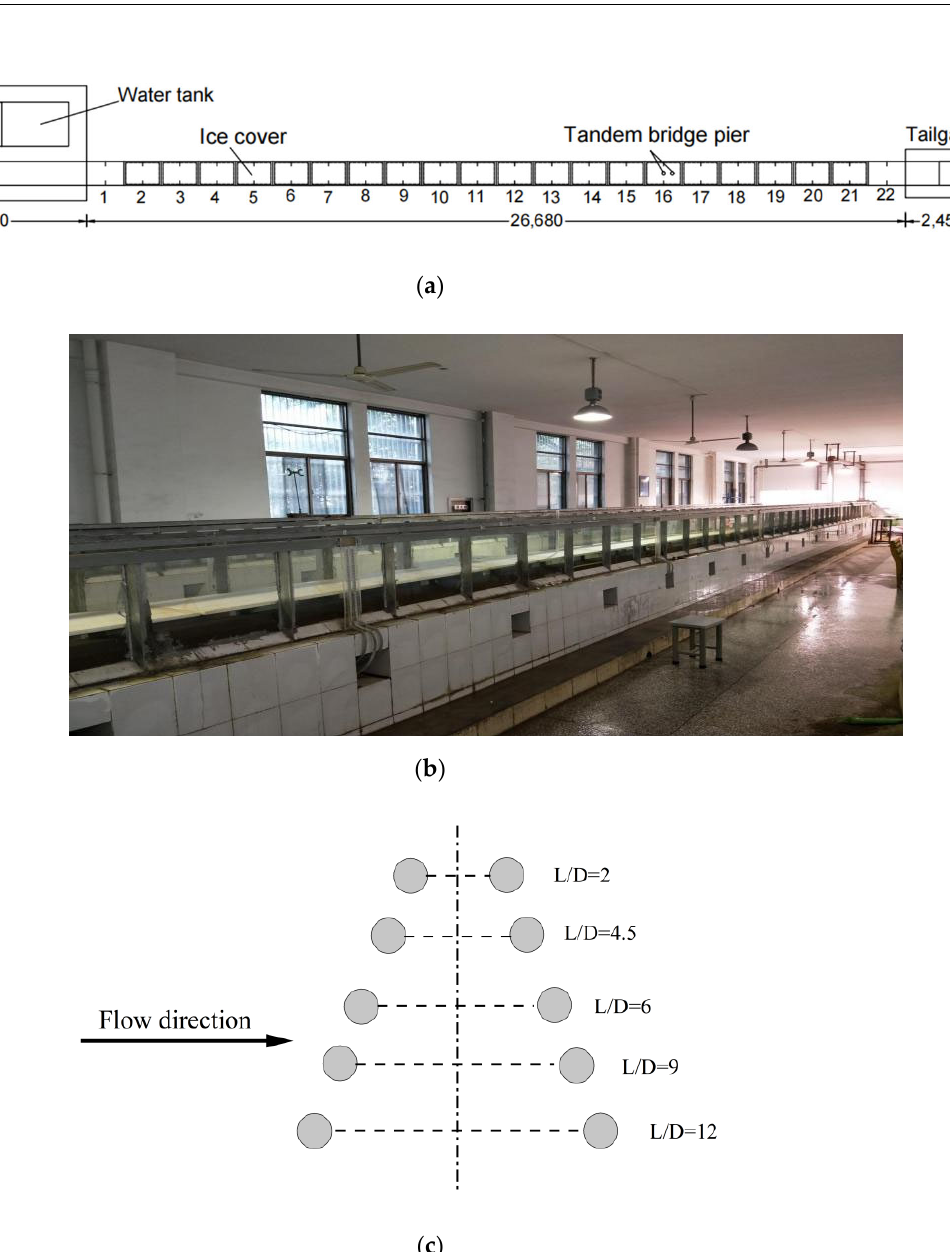
Figure 1. ( a , b ) Flume setup for experiments; ( c ) the spacing ratio of tandem double piers (unit: